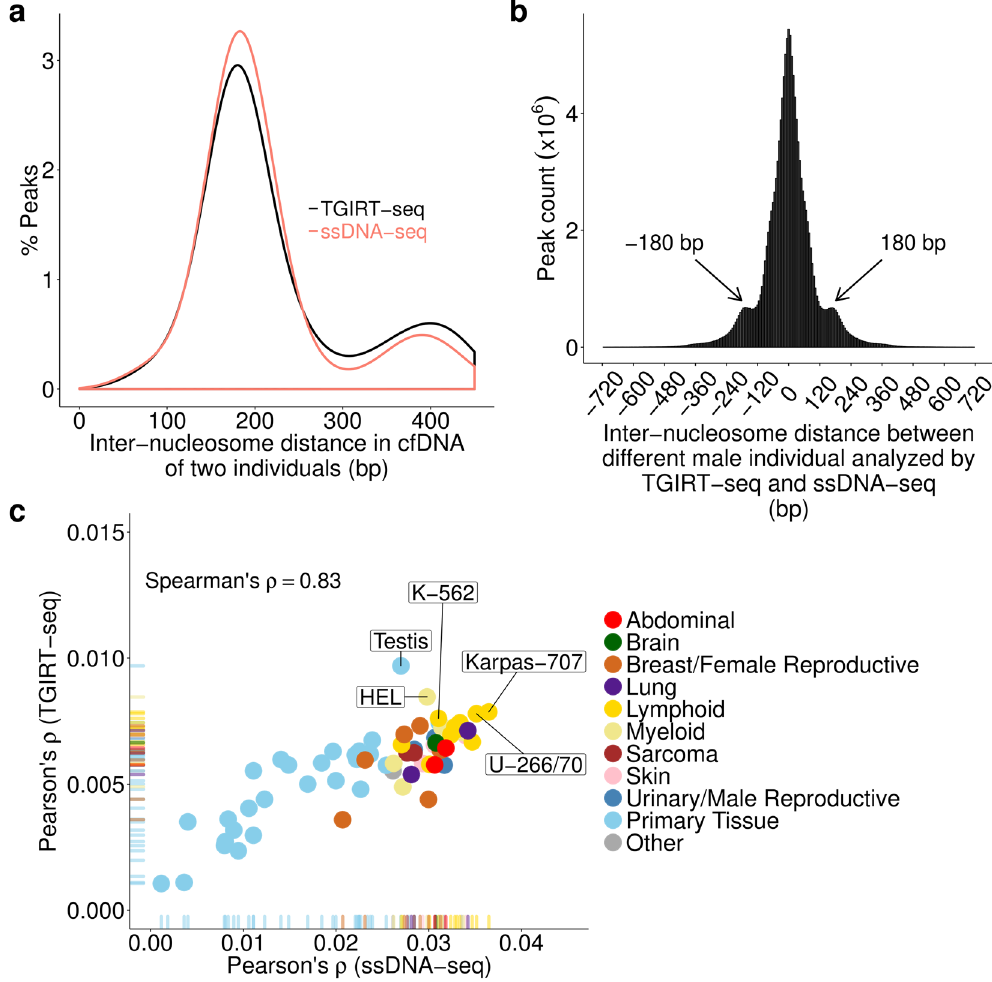
Figure 4. Comparisons of nucleosome landscapes of plasma DNA from two different healthy male individuals sequenced by TGIRT-seq and conventional ssDNA. ( a ) Plot of inter-nucleosome distances between nearest neighboring nucleosome centers in plasma DNA from two different healthy male individuals analyzed by TGIRT-seq (black line; combined datasets DP1-9) and conventional ssDNA-seq (pink line; SRR2130051). Both individuals show a peak distance of ~180 bp between nucleosome centers in their plasma DNA. ( b ) Histogram of distances (bin size of 6 bp) between the closest predicted nucleosome centers in plasma DNA from one healthy male individual analyzed by TGIRT-seq compared to those of the other healthy male individual analyzed by conventional ssDNA-seq (same datasets as panel (a)). Most predicted nucleosome centers having a nearest neighbor within ± 1 kb are at the same position (distance = 0) or within one inter-nucleosome distance (subpeaks at 180 bp upstream or downstream) between the two individuals. ( c ) Tissues-of-origin of plasma cfDNA in the two healthy male individuals analyzed by TGIRT-seq and ssDNA-seq. Tissues-of-origin were calculated by correlating nucleosome occupancies in plasma DNA with gene expression levels for different cell lines and tissues in a published database 39 as described by Snyder et al . 6 . Nucleosome occupancies within 10 kb downstream of a transcription start site in plasma DNA were calculated from the Fourier transform of the average intensity for 190–199 bp periodicity of window protection peaks and used to predict if a gene is expressed. The negative Pearson’s correlation coefficients ( ρ ) between spacing signal intensity and gene expression were used to rank tissue contributions. The overall Spearman’s rank-order correlation between the tissue rankings from TGIRT-seq and ssDNA datasets is 0.83. The most abundant sources of plasma DNA in both healthy male individuals are blood lymphoid and myeloid cells. The top 5 cell line and tissue matches for TGIRT-seq are labeled (HEL, erythroblast cell line; Karpas 707, human myeloma cell line; U266/70, B lymphocyte; K562, erythroleukemia cell